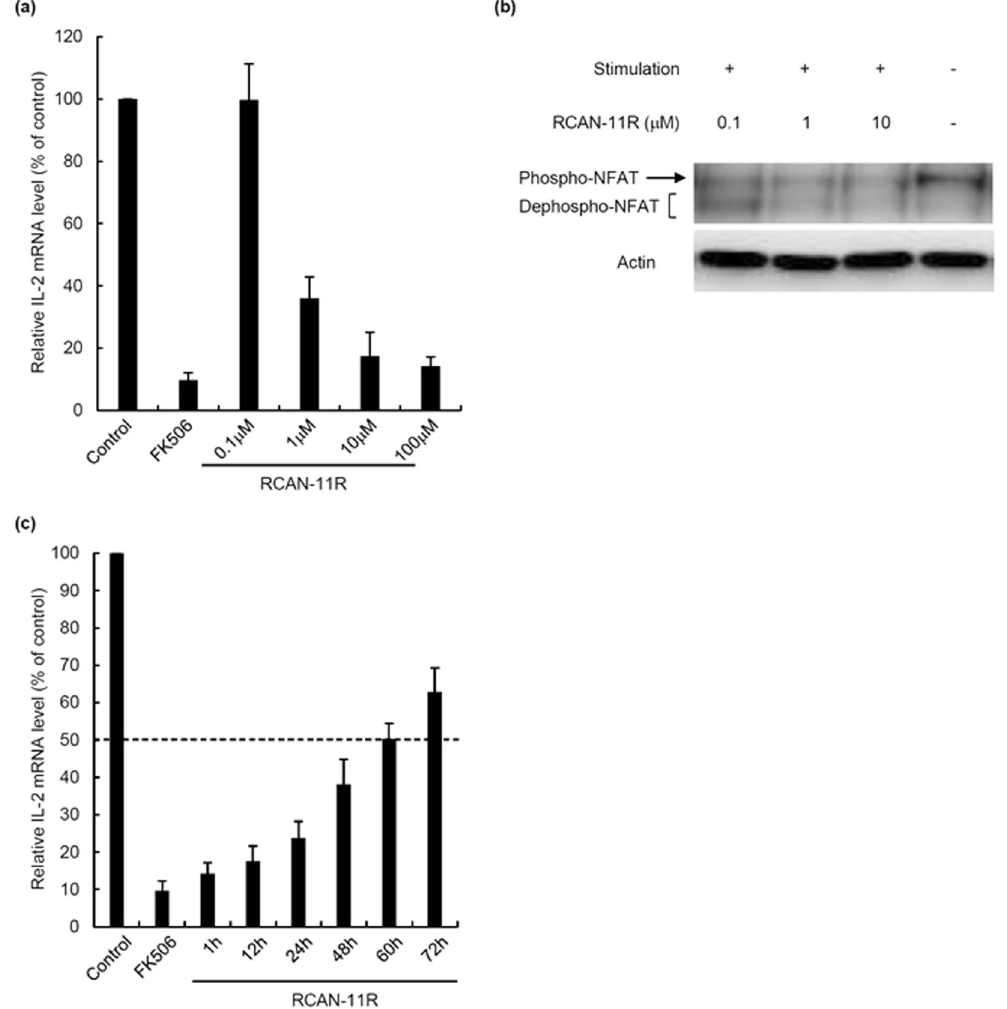
Figure 3. The dose-response and half-life of RCAN-11R. ( a ) The dose-response of RCAN-11R. Jurkat cells were treated with 0.1–100 μ M RCAN-11R or 1 μ M FK506 for 1 h, then with 200 nM PMA and 4 μ M ionomycin for an additional 12 h. The cells were subjected to a quantitative RT-PCR. ( b ) Dephosphorylation of NFAT. Jurkat cells were treated with 0.1, 1, or 10 μ M RCAN-11R for 1 h and with 20 nM PMA and 300 nM ionomycin for an additional 15 min and then western blot was performed. ( c ) The half-life of RCAN-11R. Jurkat cells were treated with 20 μ M RCAN-11R for periods of 1–72 h or with 1 μ M FK506 for 1 h, then with 200 nM PMA and 4 μ M ionomycin for an additional 12 h. The cells were then subjected to a quantitative RT-PCR. The values represent the mean ± SE of five independent